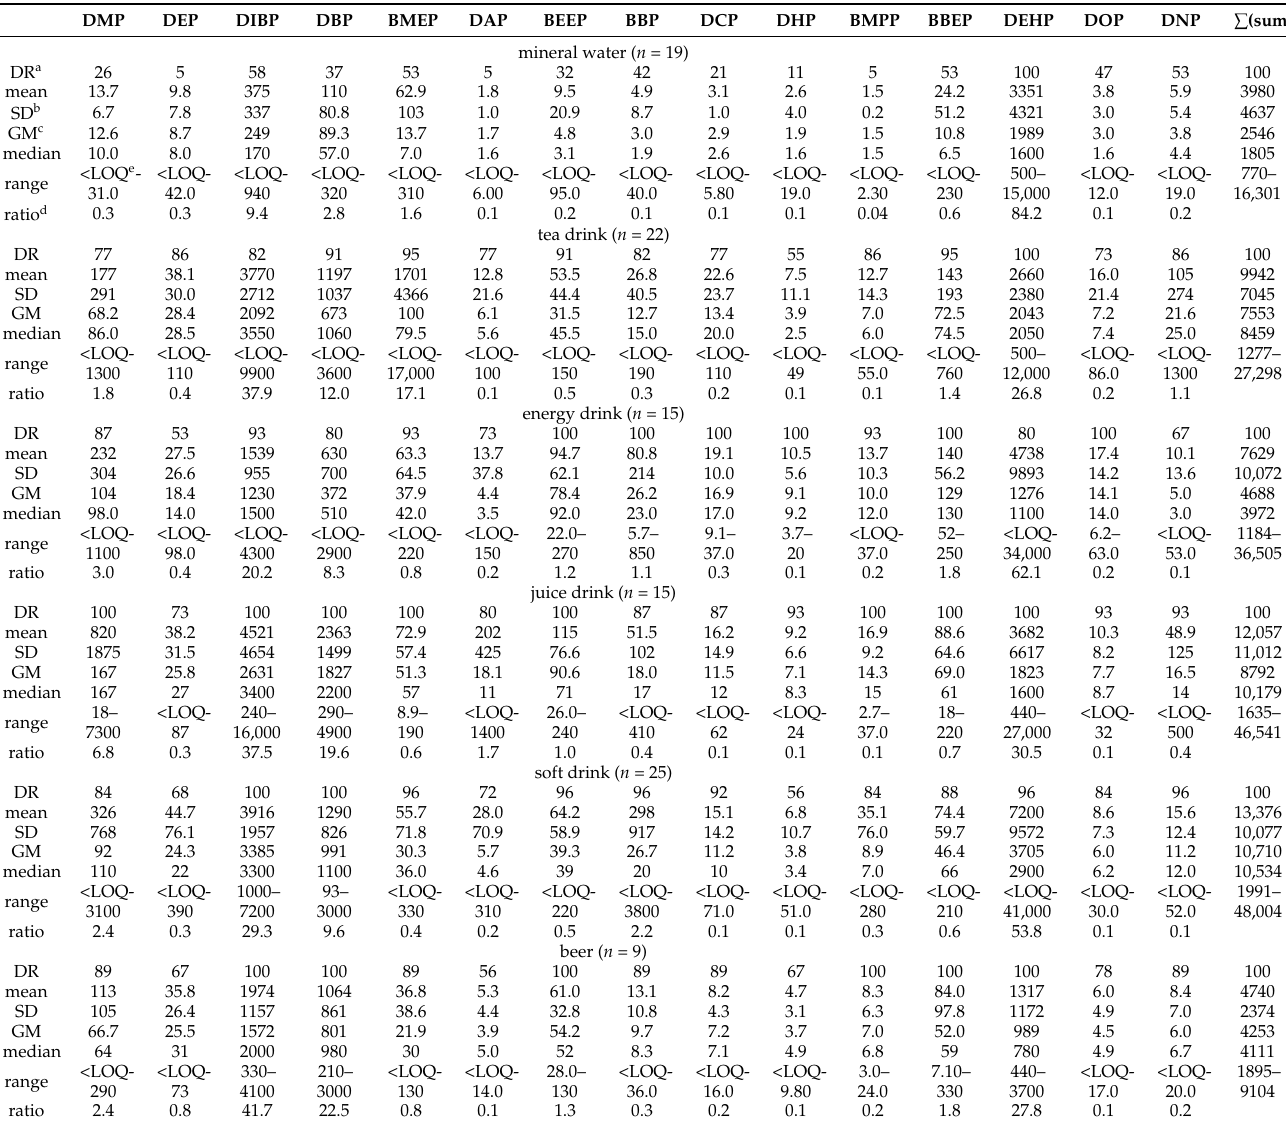
Table 3. Concentrations (ng/L) of phthalates in different types of bottled